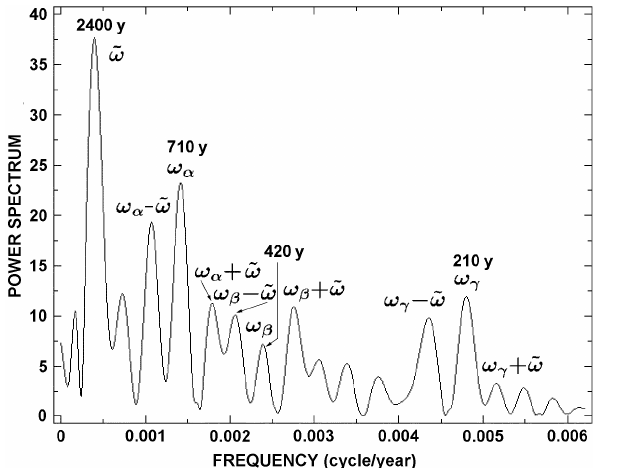
Fig. 3. The power spectrum of radiocarbon series 1 14 C D . The horizontal axis is the frequency, the vertical axis is the normalized power spectral density. A number denotes the period (years) of pri- mary spectral components. A Greek symbol shows the frequency of primary and side lines (see Table 1).